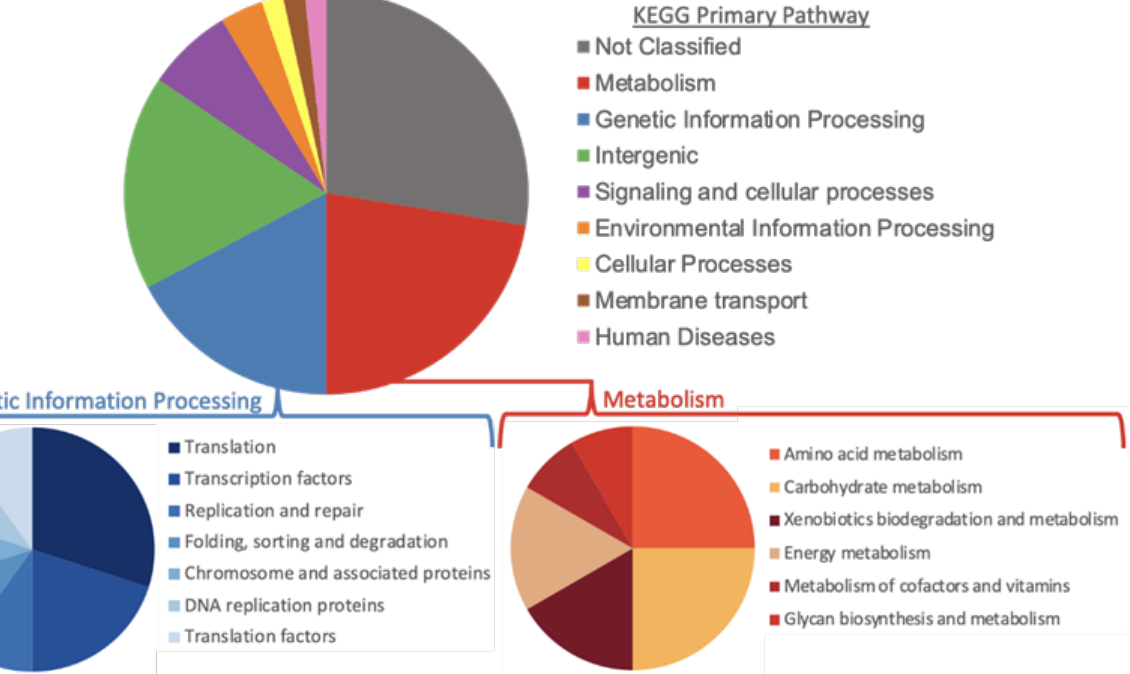
Figure 4. Overview of KEGG pathway classification of the 58 SNPs of interest that differ between Salmonella Infantis pESI plasmid carriage and those that do not carry the plasmid.